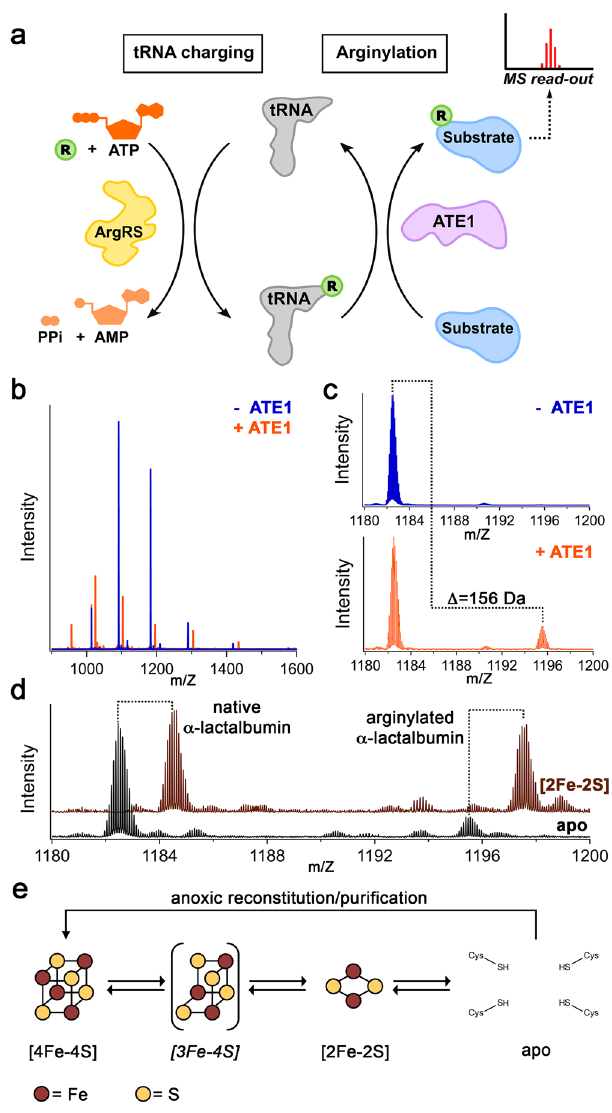
Fig.4| Sc ATE1-catalyzedarginylationisaffectedbythe[Fe-S]cluster.a Cartoon schematicoftherecombinantarginylationassay.ThearginylatedtRNA(ArgtRNA Arg ) is generated by arginine synthetase (ArgRS) aminoacylation. Arginylation of the substrate is catalyzed by ATE1, which is characterized by mass spectrometry. b The arginylationofamodelsubstrate( α -lactalbumin)is Sc ATE1-dependent,asevidenced by the shift in the top-down mass spectral envelope of α -lactalbumin in the absence of Sc ATE1(blue)andthepresenceof Sc ATE1(orange). c Close-upofthemassspectral window from 1014m/Z to 1028m/Z. The change in molecular weight ( Δ =156g/mol (Da)) is consistent with a single arginylation event after considering the charge (+14) of the polypeptide. d In the presence of the [2Fe-2S] 2+ cluster-bound form of Sc ATE1 (brown spectrum), the extent of arginylation of α -lactalbumin is increased ca . two- fold on average compared to apo Sc ATE1 (black spectrum). For ease of interpreta- tion,thebrownspectrumisoffsetby2m/Zrelativetotheblackspectrum. e Cartoon synopsis of the cluster-bound forms of Sc ATE1. The [4Fe-4S]- and [2Fe-2S]-cluster- boundformsmaybeinterconvertedinanO 2 -dependentmanner,througha[3Fe-4S] intermediate. We believe a [4Fe-4S] cluster is operative under anoxic conditions in thecelluntilareactionwithO 2 convertstheclusterto[2Fe-2S],andweobservesuch behavior when Sc ATE1 is puri fi ed and/or reconstituted under anoxic conditions and subsequently exposed to O 2 . Source data are provided as a Source Data fi